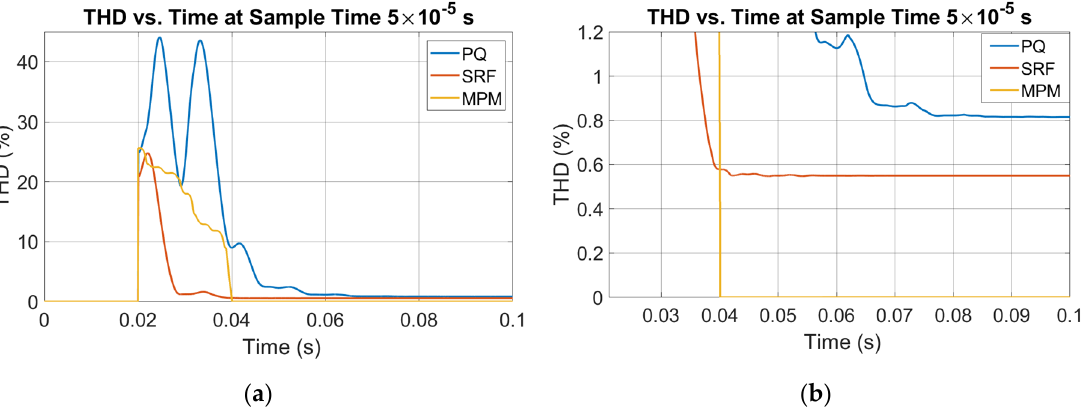
Figure 3. THD measurement vs. time in transient state at sample time 5 × 10 − 5 s ( a ) overall figure and ( b ) enlarged figure.